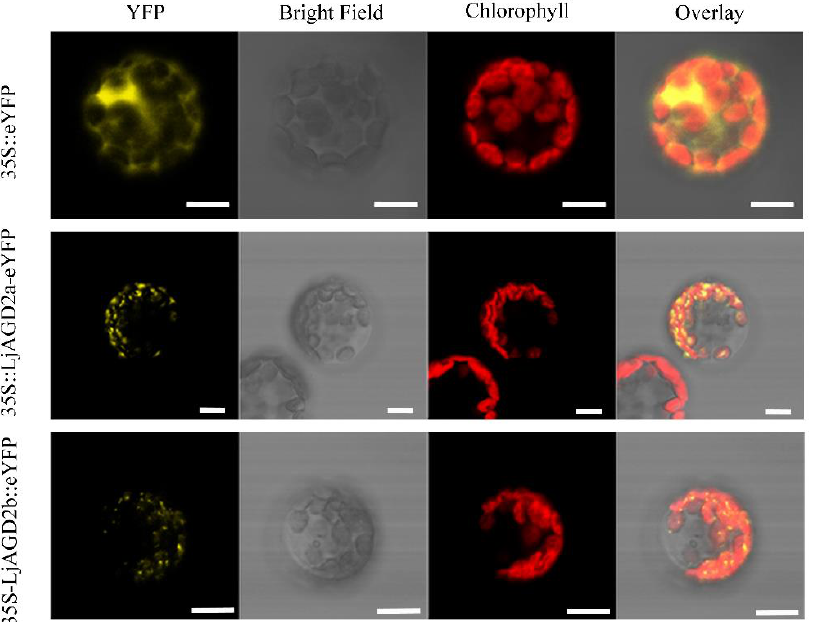
Figure 2. Subcellular localization of LjAGD2a and LjAGD2b. LjAGD2a-eYFP and LjAGD2b-eYFP images indicating the localization of LjAGD2a and LjAGD2b in the chloroplasts of Arabidopsis protoplasts. The top row of images indicates the control. Scale bar = 10 µm.